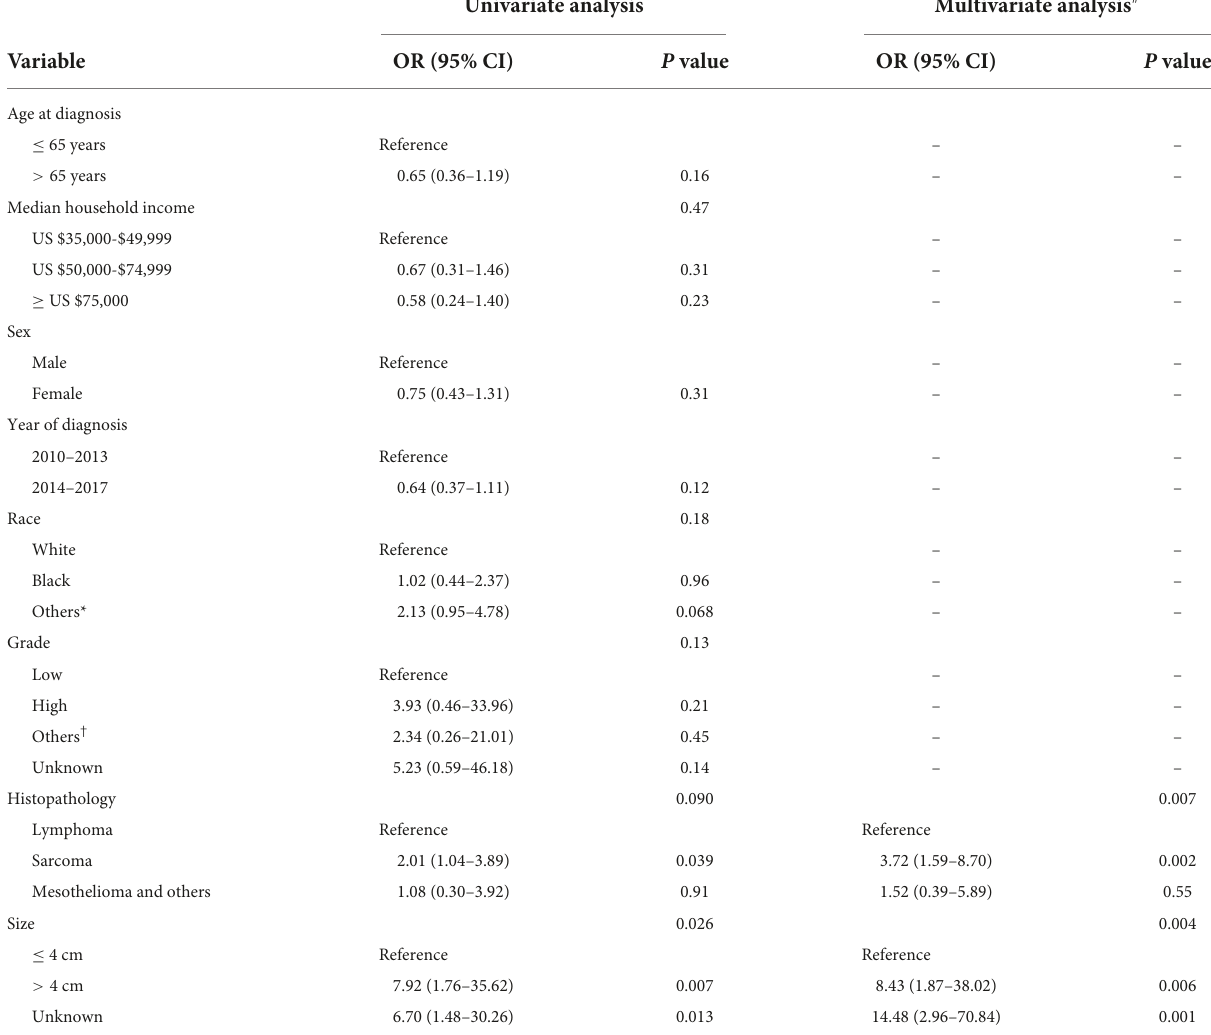
TABLE 2 Logistic regression analyses of the risk factors for